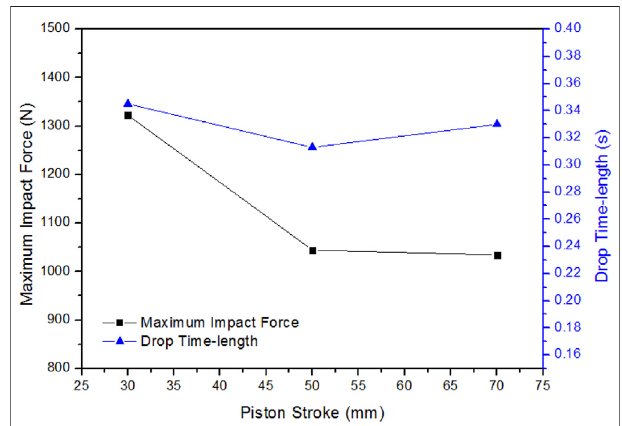
FIGURE 6 | The effects of piston stroke on the maximum impact force and the drop time-length.